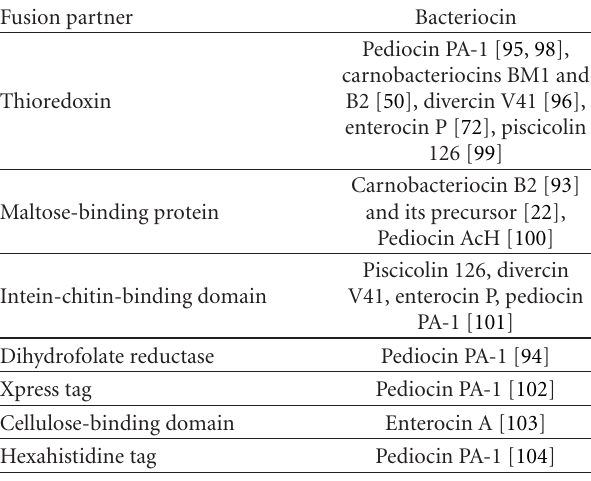
Table 1: Fusion partners used for class IIa